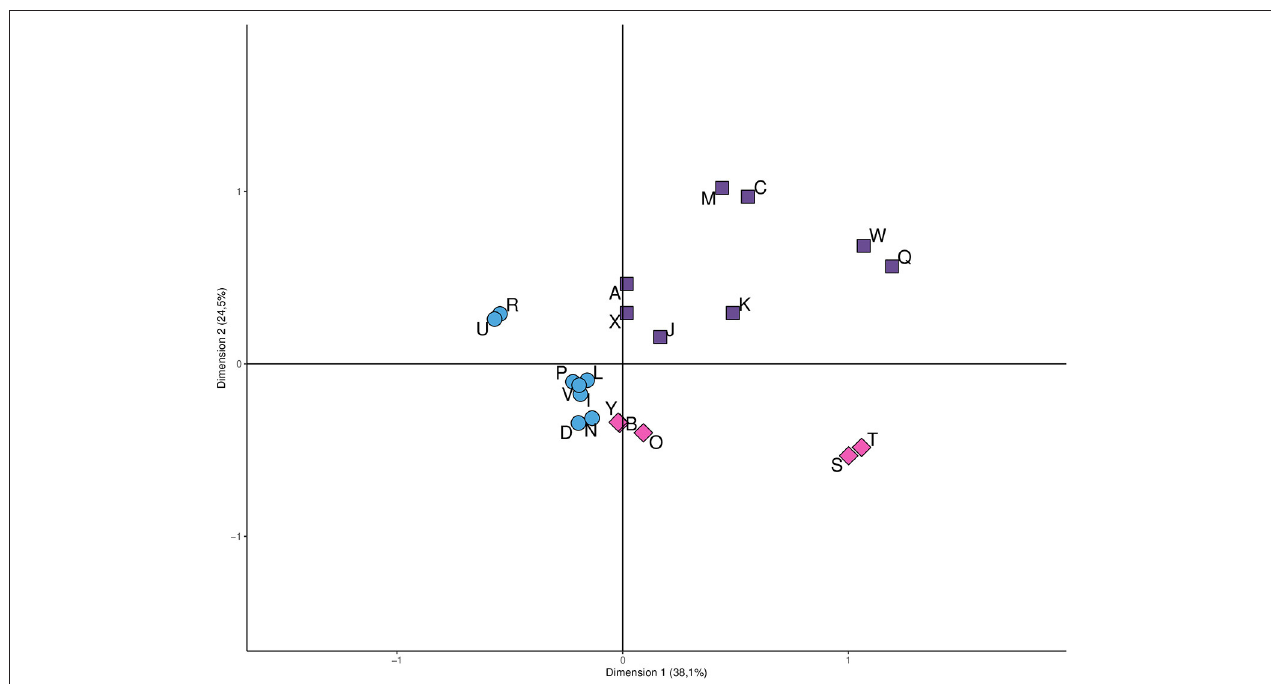
FIGURE 1 | Clustering of variables associated with the potential exposure of hunters to avian influenza viruses. Symbols with the same shape or color belong to the same cluster and their particular characteristics appear below in correspondence with the letter that identifies them. Cluster 1: Clean birds at home (D), High hunter experience (I), Have knowledge on avian influenza (L), Direct contact water (N), Clean knives after slaughtering (P), Don’t smokes (R), Flu unvaccinated (U), Washing hands after hunt (V); Cluster 2: Don’t hunt with dog (A); Don’t clean birds at home (C), Low hunter experience (J), haven’t knowledge on avian influenza (K), Haven’t direct contact water (M), Don’t clean knives after slaughter (Q), Don’t washing hands after hunt (W), Sharing hunting knives in household activities (X); Cluster 3: Hunt with Dog (B), Receives bird cleaning assistance (O), Smokes (S), Flu vaccinated (T), Don’t share hunt knives in other activities